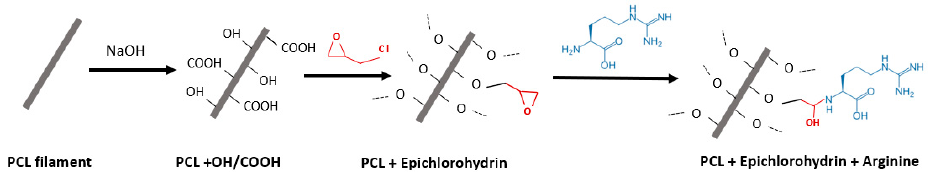
Figure 1. Schematic representation of the chemical arrangements produced during the arginine’s immobilization on the 3D-Printed PCL structure (based on Valente et al. 2020 and Pourrostam- Ravadanaq et al., 2020 [12,13]).